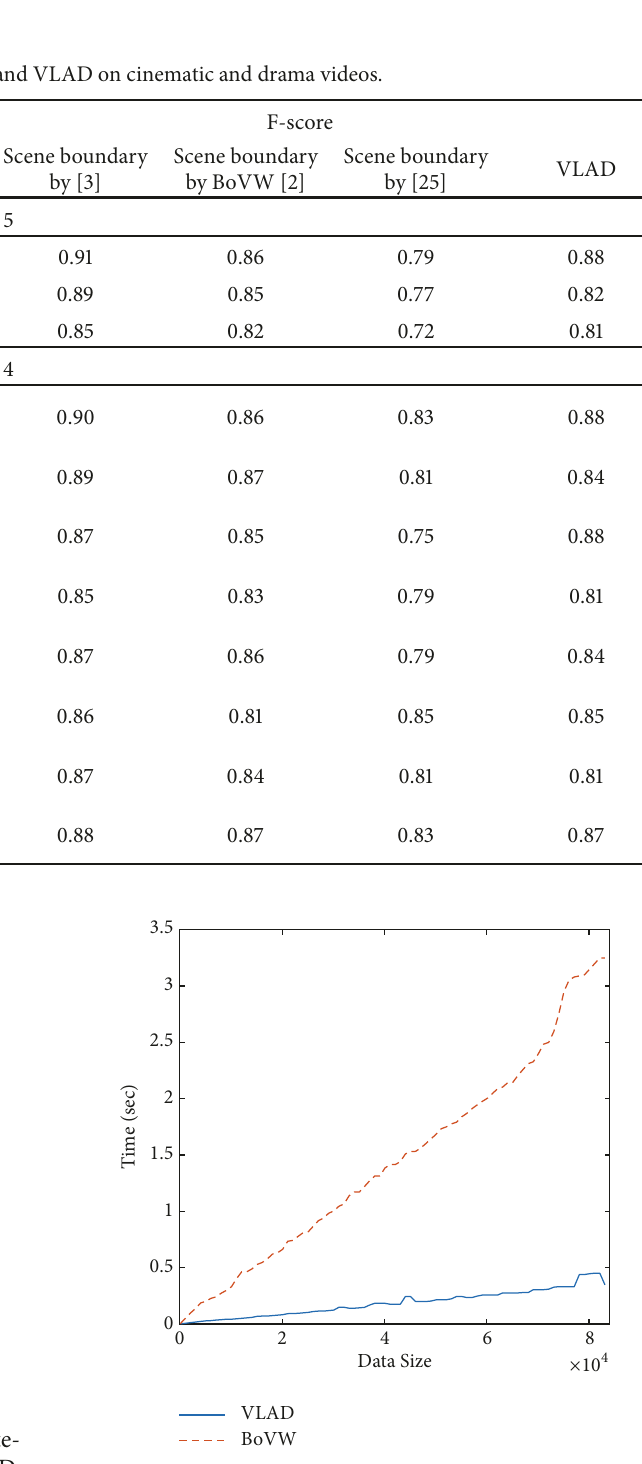
Figure 5: Timing plot of query image matching with all the images in database. VLAD always has less dimensions compared to the BoVW which makes VLAD faster than